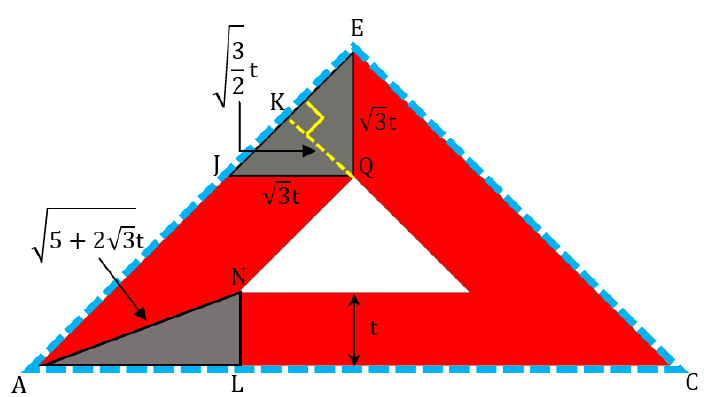
Figure 5. Cross-section of the pyramid over the blue dashed line or through A, C, and E. The grey triangles ∆EQJ and ∆ALN are used to calculate the lengths and ratios between the edges.